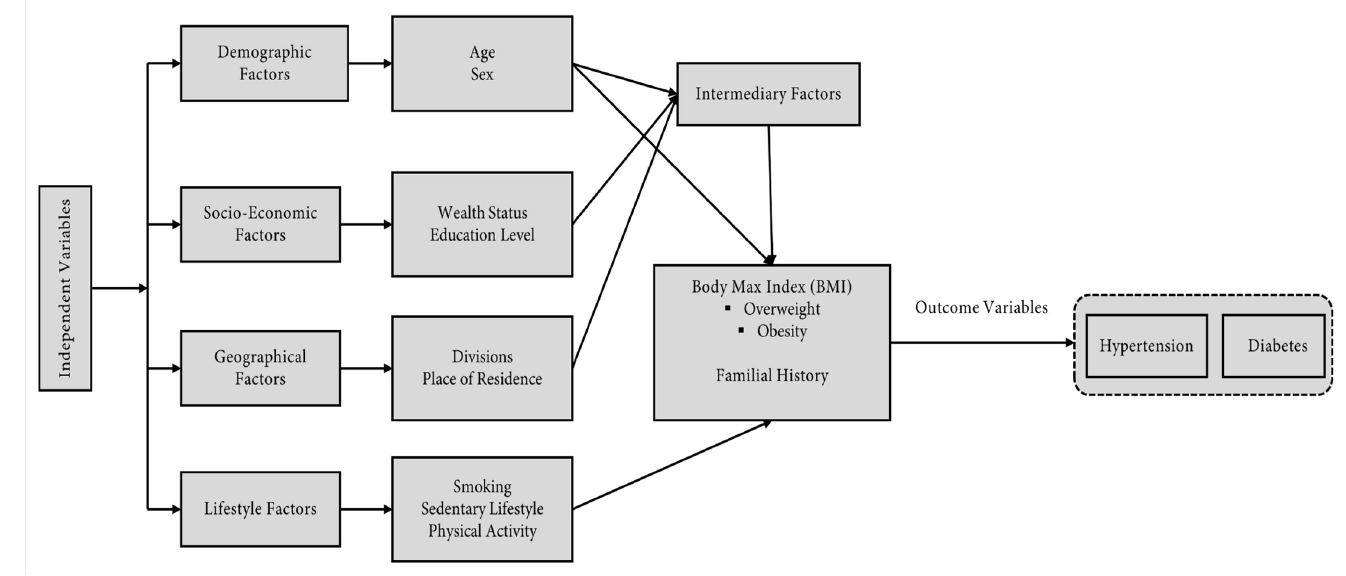
Fig 1. Conceptual framework of the